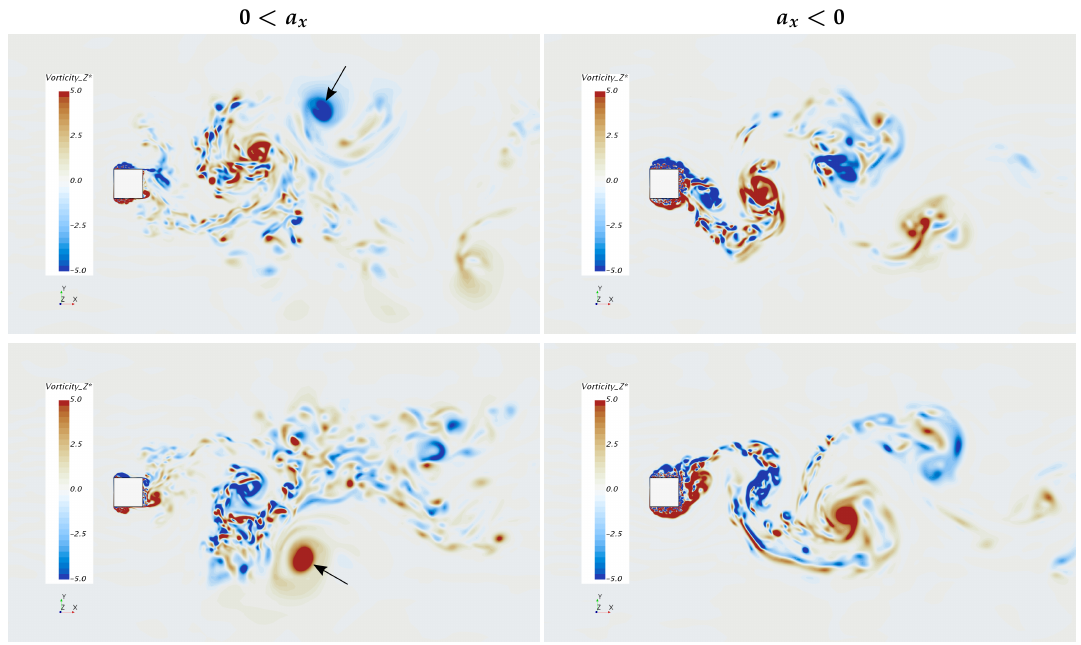
at cylinder center plane ( H ∗ z = 0) Z